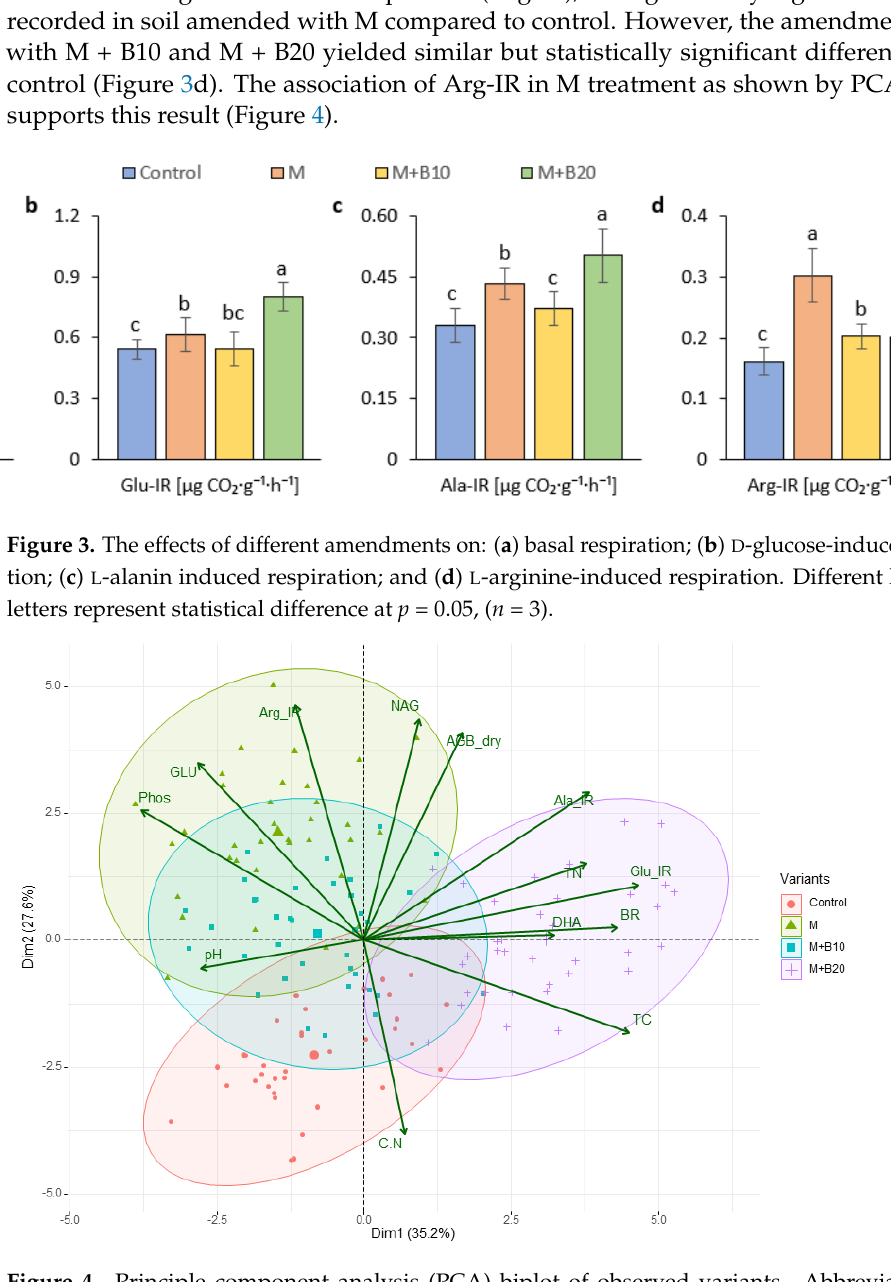
Figure 4. Principle component analysis (PCA) biplot of observed variants. Abbreviations are: AGB-dry, aboveground dry biomass; pH, soil reaction (CaCl 2 ); TN, total nitrogen; TC, total carbon; C:N, ratio of carbon to nitrogen; DHA, dehydrogenase activity; Glu, β -glucosidase activity; Phos, phosphatase activity; NAG, N -acetyl- β - D -glucosaminidase; BR, basal respiration; Glu-IR, D -glucose-induced respiration; Ala-IR, L -alanin-induced respiration, Arg-IR, L -arginine-induced respiration.